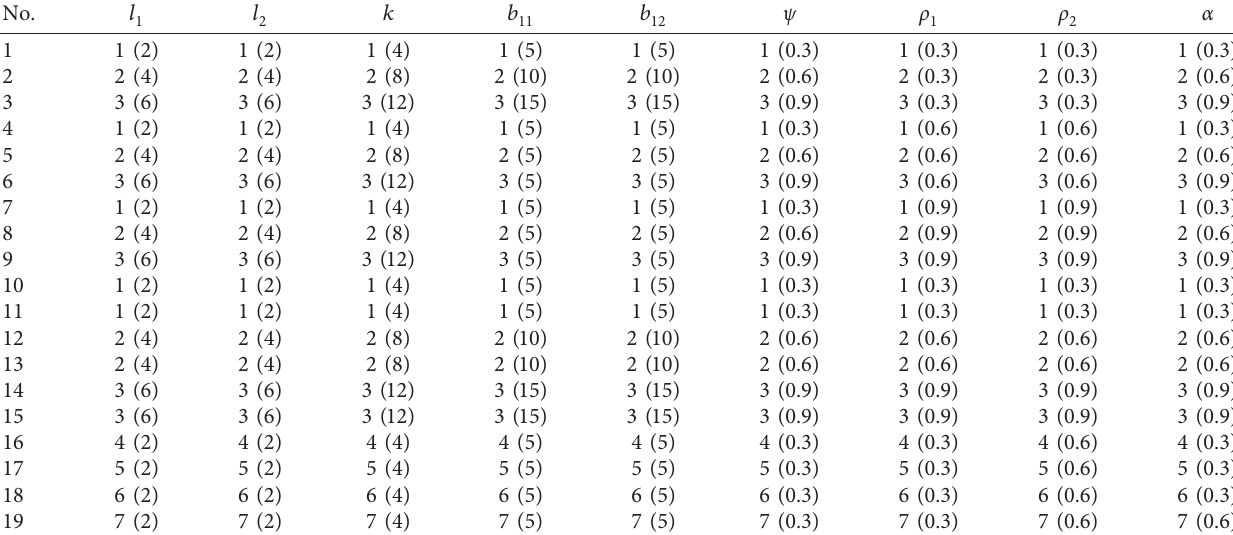
Table 3: The simulation number.